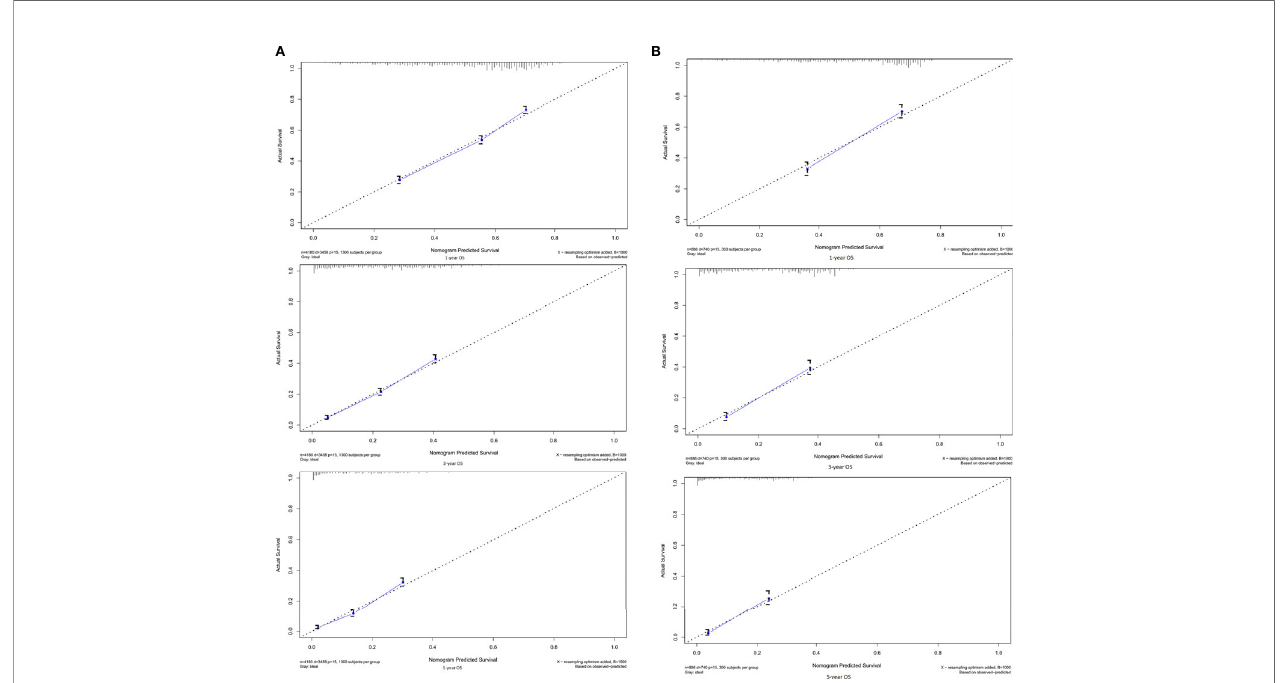
FIGURE 2 | Calibration curves for 1-, 3-, 5-OS in the (A) training and (B) validation cohorts. By plotting nomogram-predicted overall survival on x-axis and actual observed overall survival on y-axis, the closer the drawn line is to 45 degrees, the better the calibration model is (it means the predicted probabilities are more identical to the actual outcomes).